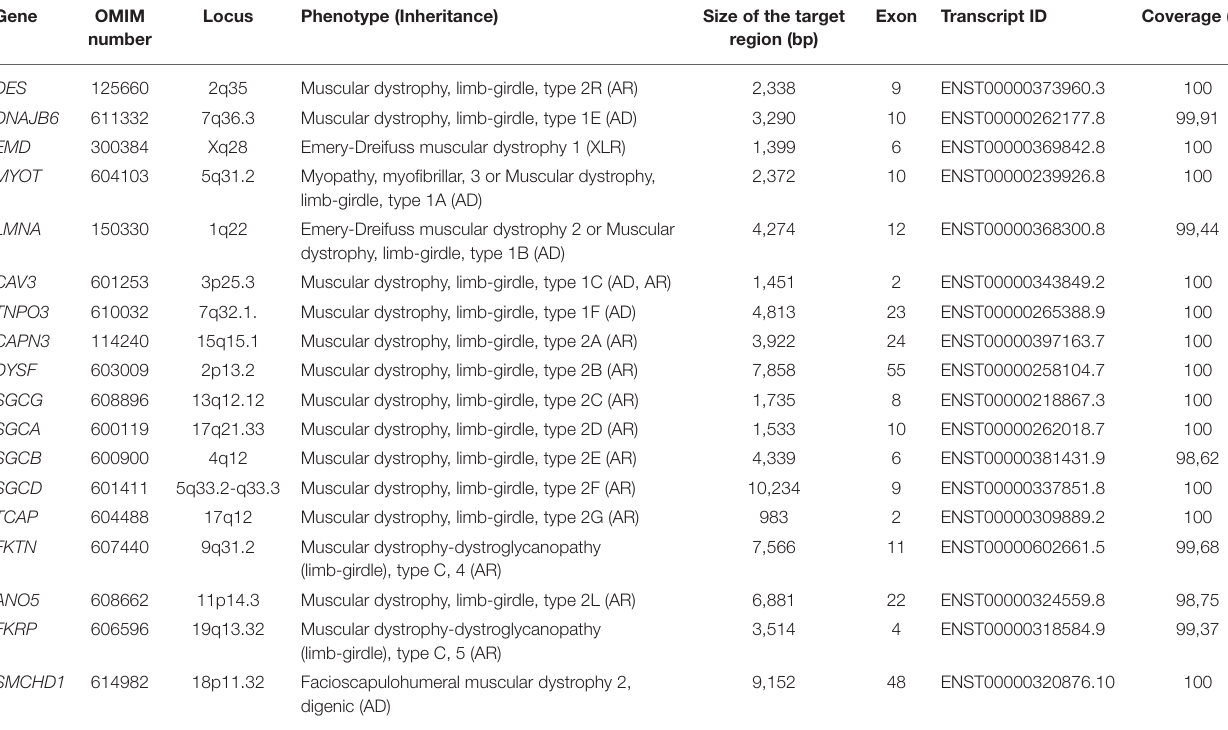
TABLE 1 | Customized NGS panel utilized for LGMD